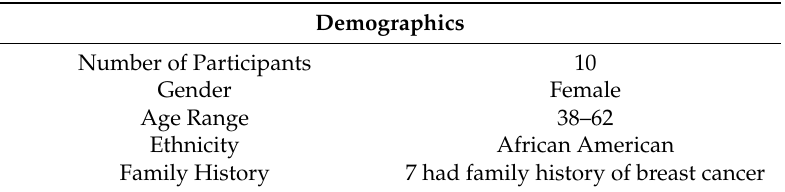
Table 1. Demographics of African American breast cancer survivors for Consortium on Health Education, Economic Empowerment and Research (CHEER) focus